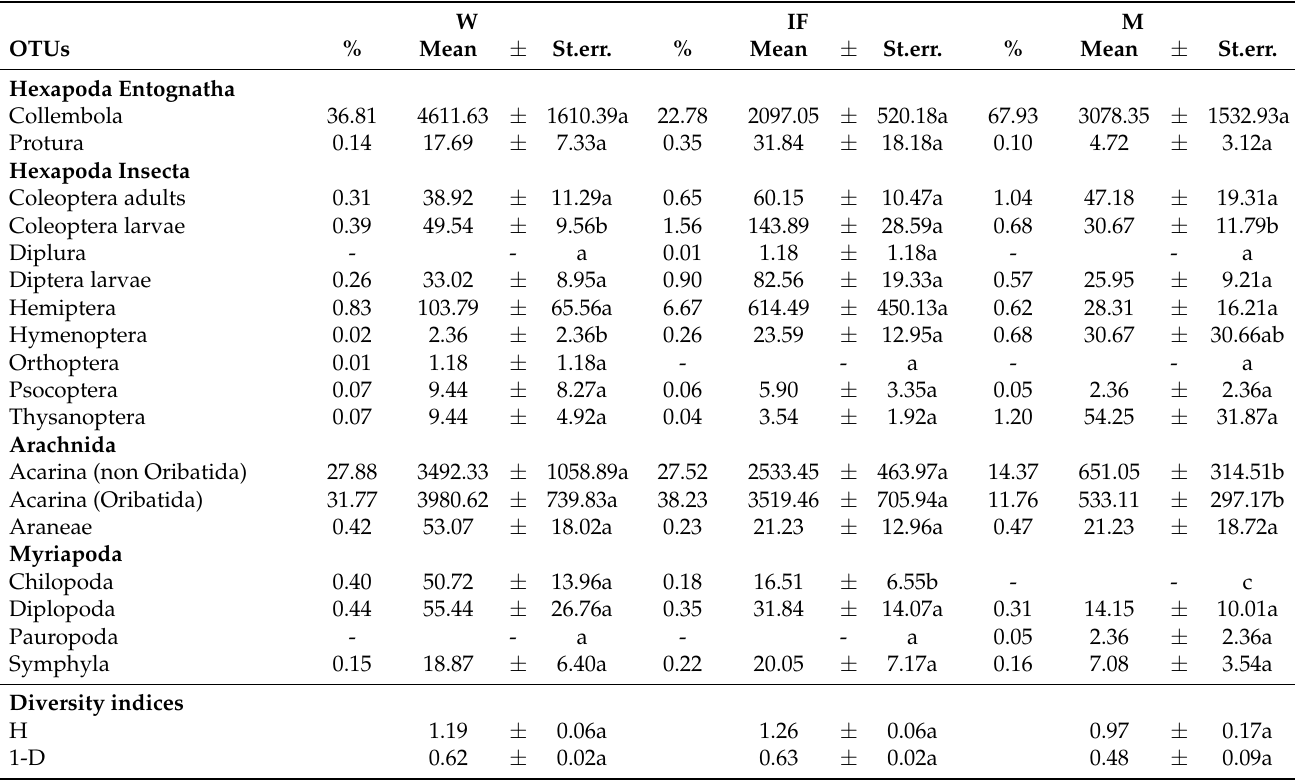
Table 1. Relative abundance (%) and mean ± st.err. of the OTU abundances (ind./m 2 ) and diversity in each condition (W: windthrow, IF: intact forest, M: meadows). Different letters mean significant differences ( p ≤ 0.05) between